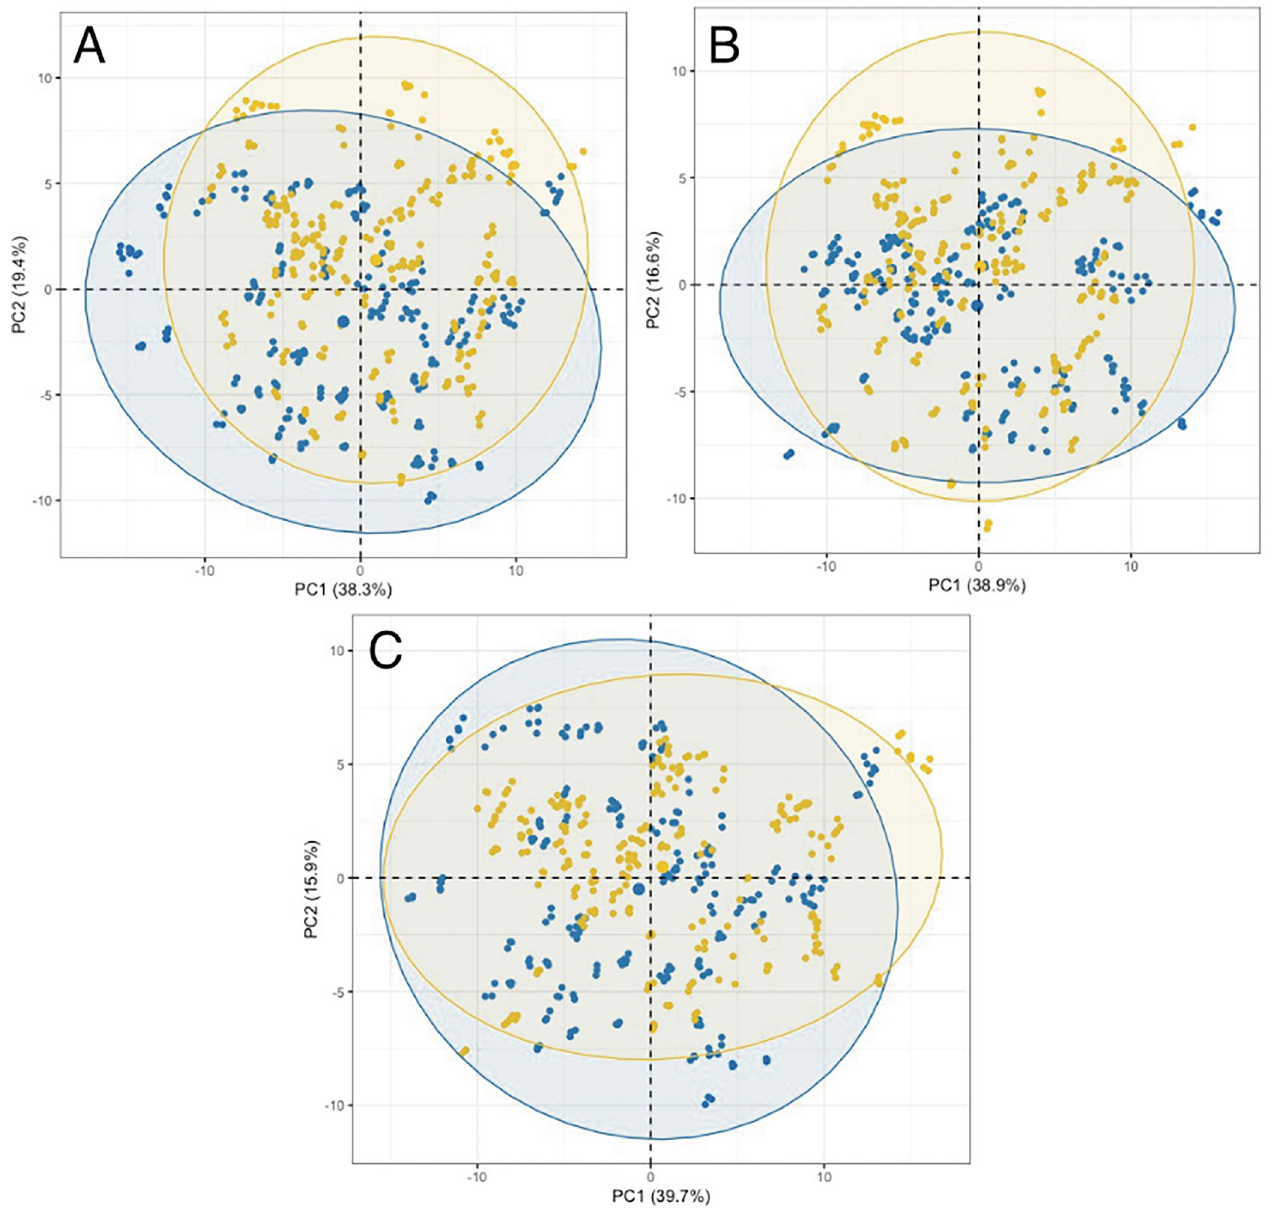
Fig 3. PCA scores plots for the filtered serum ( < 100 kDa) of the first and second dimensions. The three figures represent (A) GBM in blue and non-cancer in yellow, (B) Lymphoma in blue and non-cancer in yellow and (C) GBM in blue and lymphoma in yellow. The eclipses in each class represent a 95% confidence interval. Values in parentheses are the TEV for each